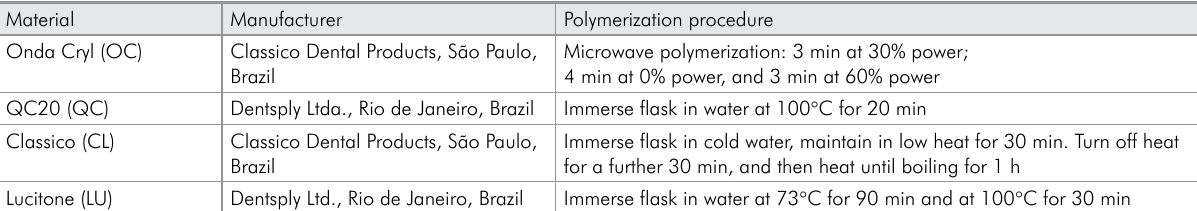
Table 1 - Polymers and polymerization procedures used in this study. Material Manufacturer Polymerization